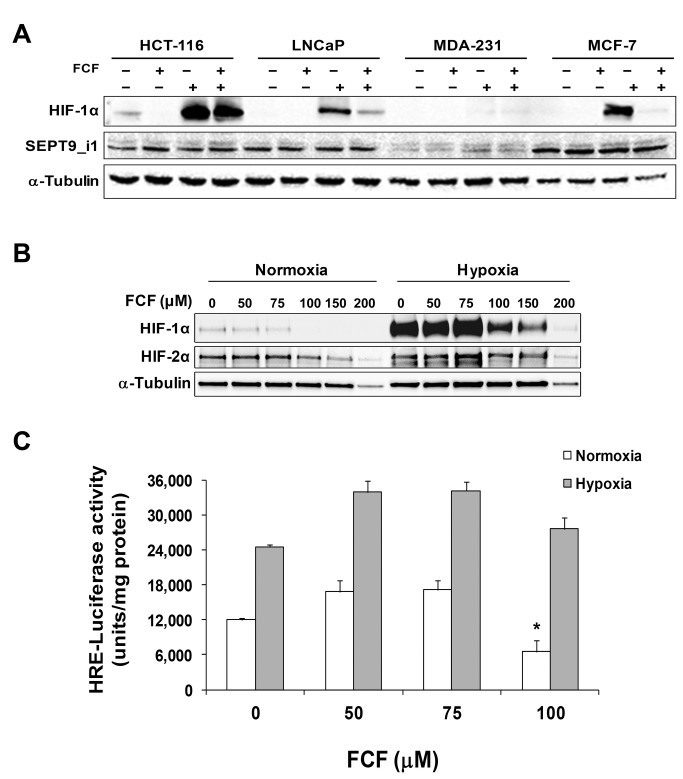
The effect of FCF on HIF-1α is general to cancer cells but specific only to HIF-1α.(A) The indicated cancer cells were treated with 100 μM FCF for 4 h under normoxia or hypoxia. Whole cellular extracts were subjected to Western blot analysis using anti-HIF-1α and anti-SEPT9_i1 antibodies. (B) PC-3 cells were treated with FCF as indicated and subjected to normoxia or hypoxia for 6 h. Whole cell extracts were analyzed by SDS-PAGE and immunoblotted with antibodies to HIF-1α, HIF-2α and tubulin. (C) PC-3 cells were transiently transfected with reporter plasmid expressing luciferase under the control of PTHrP P2 promoter (specific to HIF-2α). After 24 h of transfection, the cells were pretreated with FCF for 2 h and then subjected to normoxia or hypoxia for 48 h. Whole cell extracts were analyzed by luciferase luminescence assay. Arbitrary luciferase activity units were normalized to the amount of protein in each assay point. Columns, mean (n = 3); bars, SD. *P < 0.05.